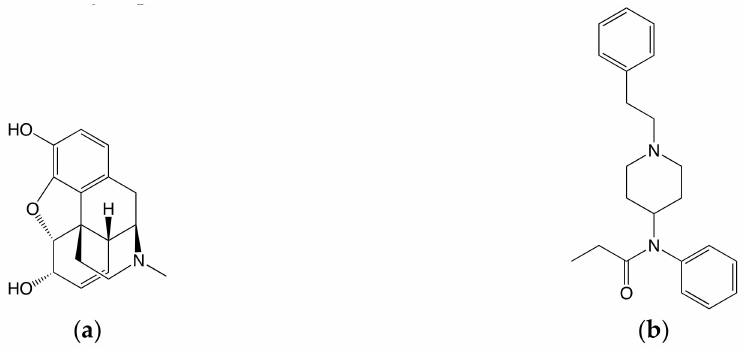
Figure 3. Chemical structures of µ OR agonists: ( a ) morphine; ( b )